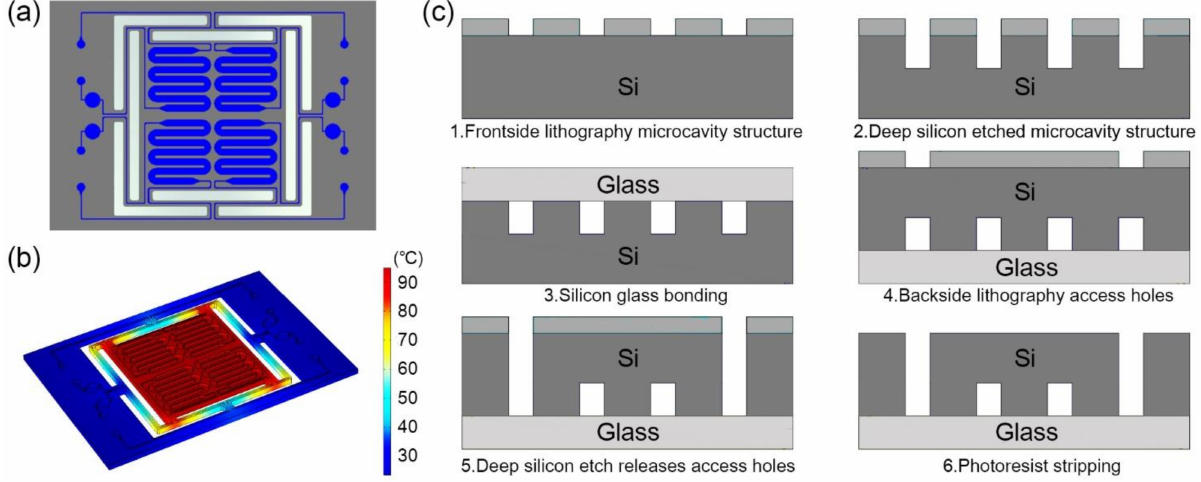
Figure 1. ( a ) Schematic diagram of the microfluidic chip. The chip is composed of four serpentine- shaped microchannels, and the buffer pool at the outlet can store the excess reagents. ( b ) Thermal simulation diagram when heating to 95 ◦ C. The design of the insulation trench can make the main part of the chip maintaining temperature uniformity. ( c ) Schematic diagram of processing flow of microfluidic silicon-based